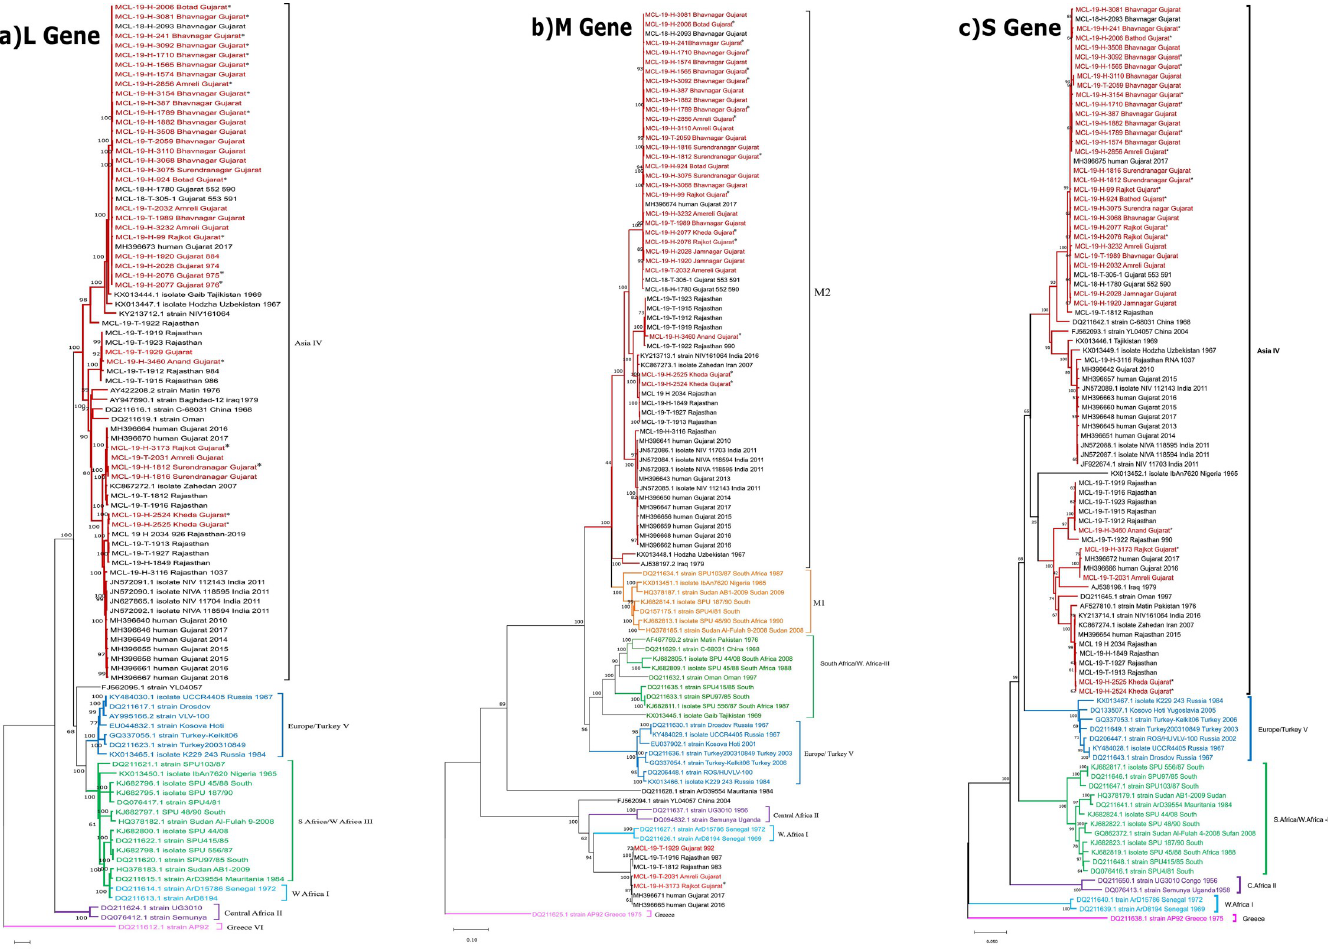
Fig 5. Phylogenetic tree for the L M and S genes for the CCHFV (depicted in A, B and C respectively). Maximum-Likelihood tree for CCHFV sequences retrieved from the clinical samples of the Gujarat state. The tree was constructed using the representative clades downloaded from Genbank using the General-time reversible model with gamma distribution as the rate parameter. The bootstrap replication of 1000 cycles was used to assess the statistical robustness of the generated tree. The scale depicts the number of base substitutions per site. Clades are marked in different colours. � indicates the fatal CCHF